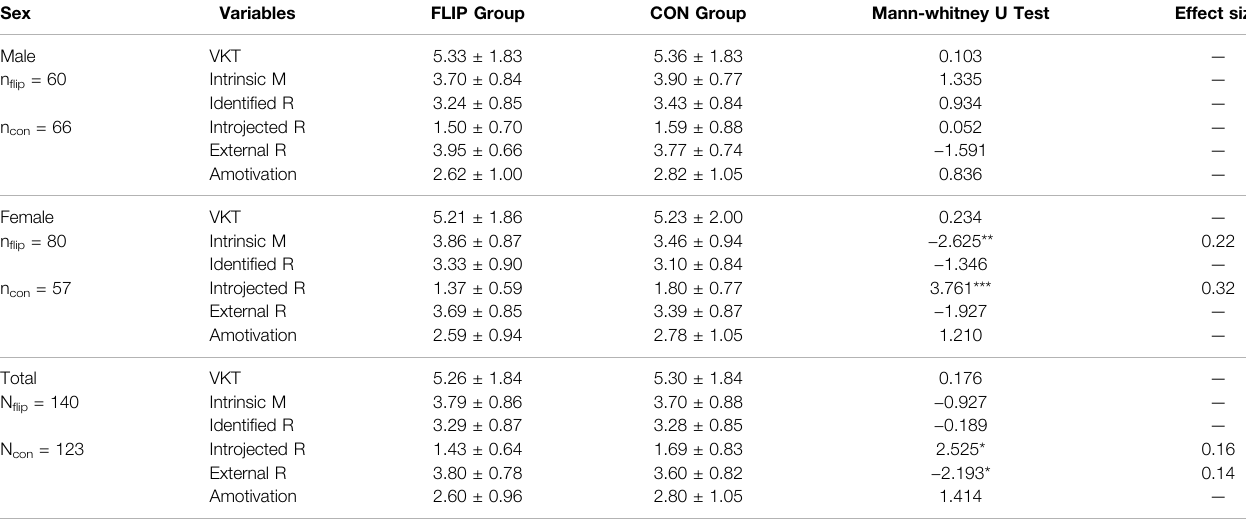
TABLE 3 | Comparing variables between FLIP and CON at pre-test using Mann-Whitney U test according to sex (Av ± SD). Sex